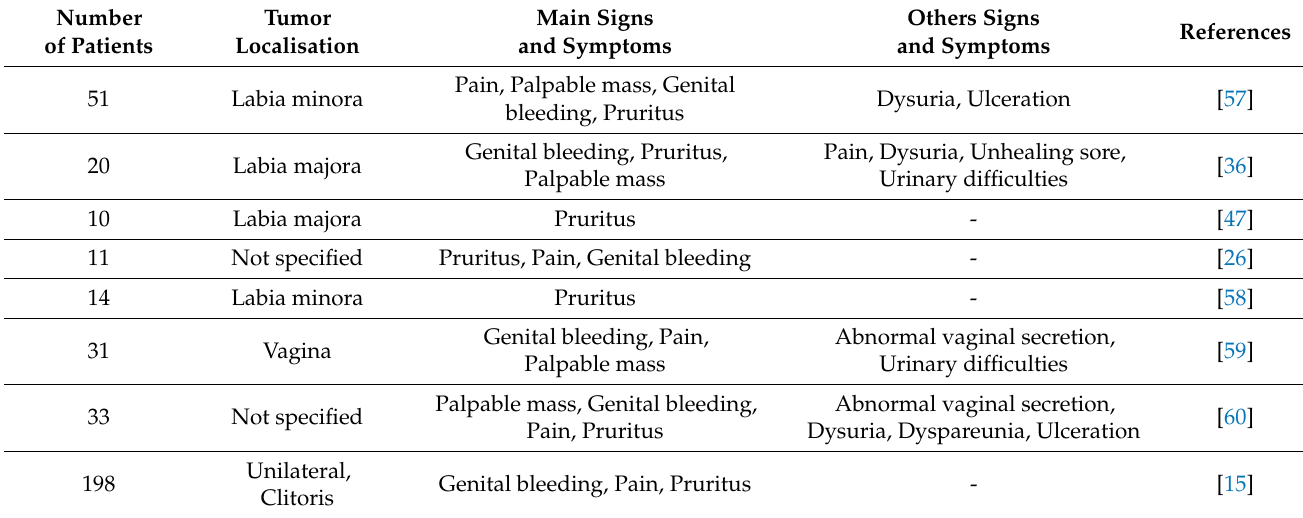
Table 1. Clinical findings in melanoma of the vulva and vagina